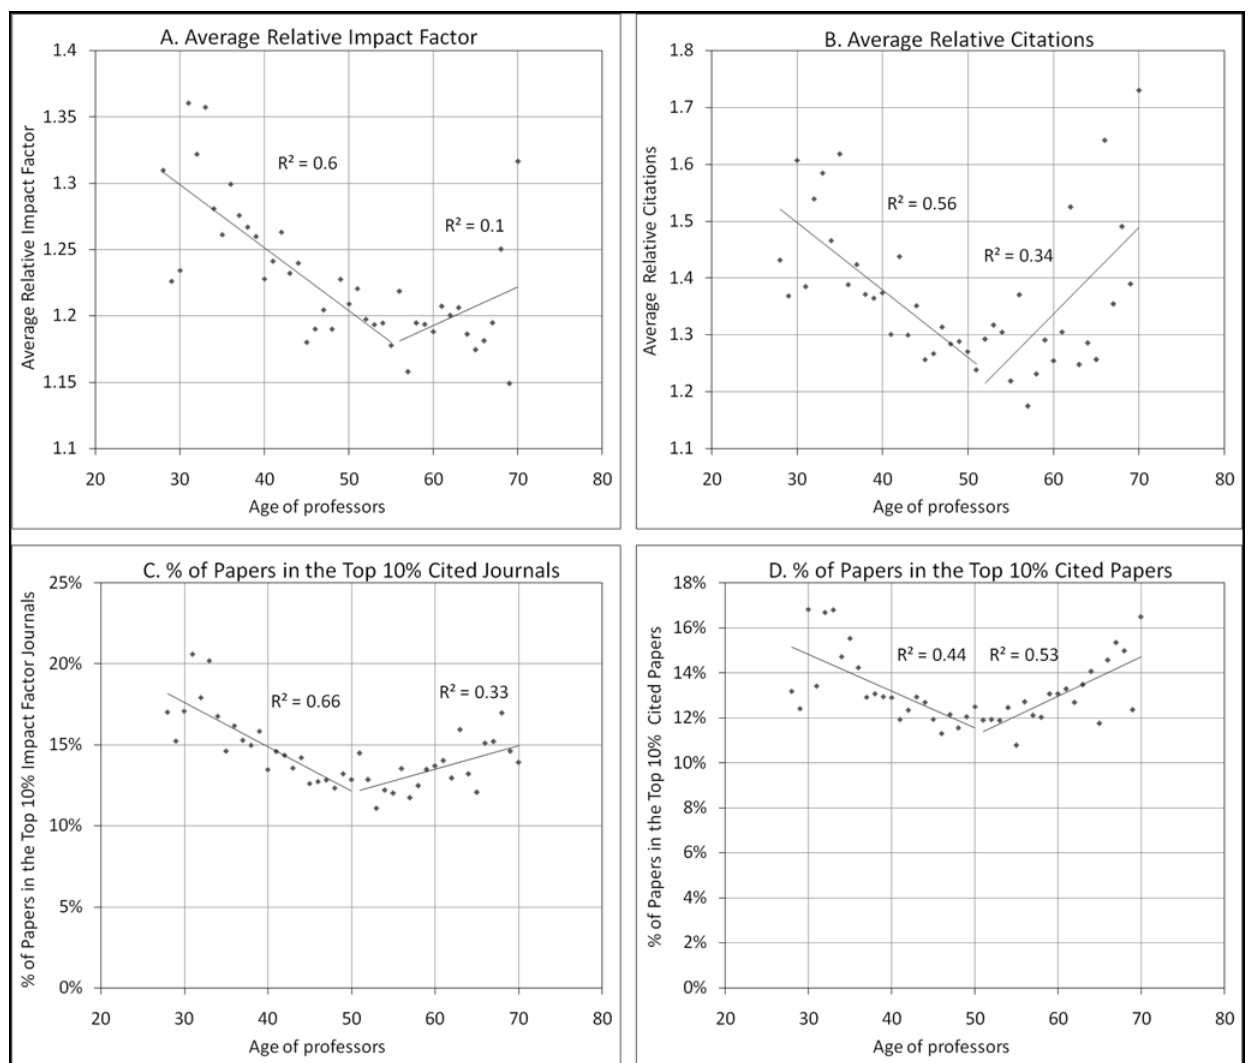
Figure 4. Distribution of paper research impact by professor age. A) Average relative impact factor (ARIF) B) Average relative citations (ARC) C) Percentage of papers in the top 10% cited journals D) Percentage of papers in the top 10% cited papers.